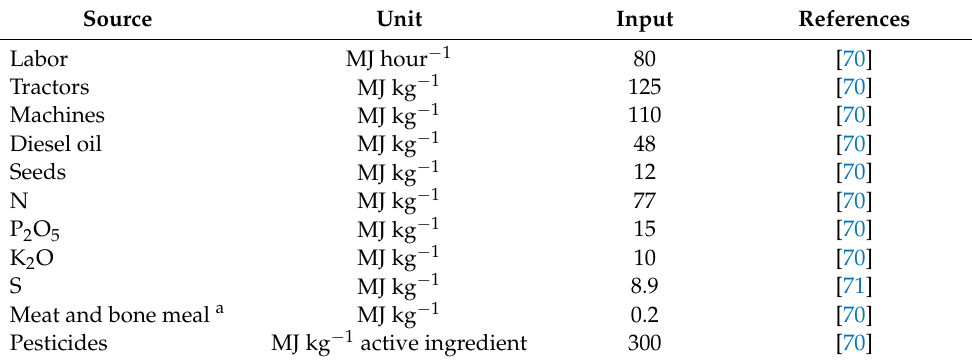
Table 3. Energy equivalents of inputs associated with the production of winter oilseed rape.